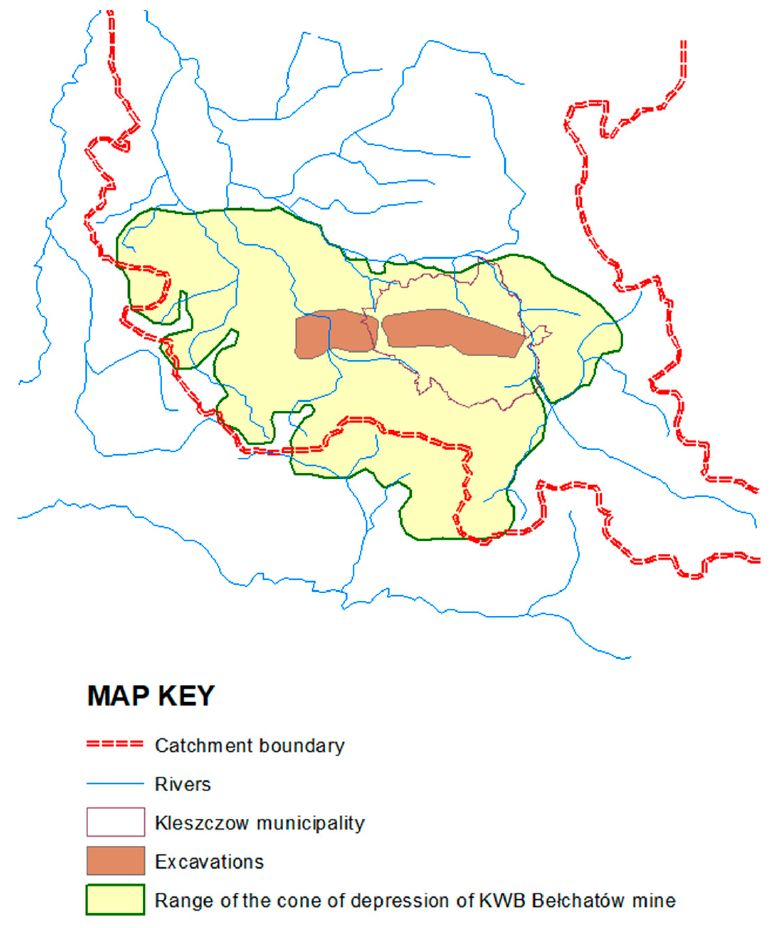
Figure 8. Extent of the subsidence cone of the KWB Bełchat ó w mine (source: own elaboration based on data from the assessment of runoff changes in the Widawka river basin).